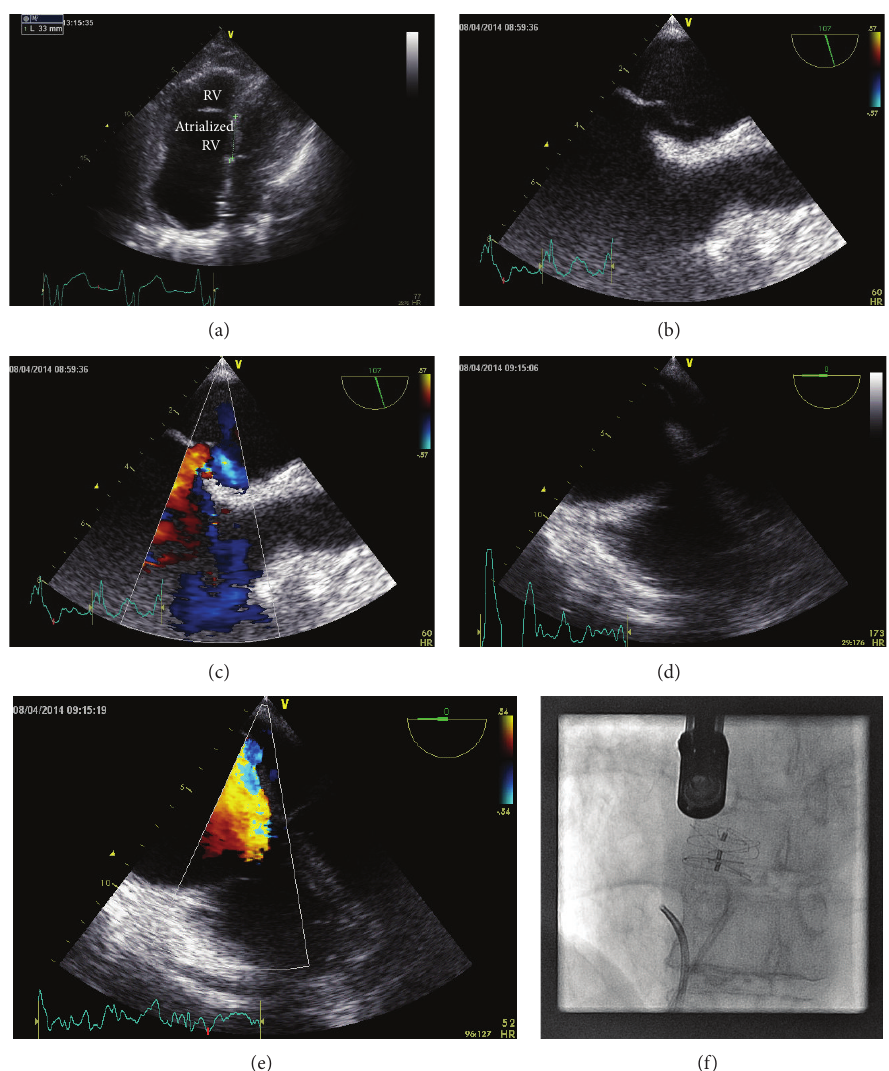
Figure 1: (a) TTE apical four-chamber view, focused on the right heart, showing Ebstein anomaly with atrialization of the right ventricle. (b) TEE image (107 degrees) showing the patent foramen ovale (arrow). (c) TEE image (107 degrees) with color Doppler, showing the patent foramen ovale. (d) TEE four-chamber view (0 degrees) showing the tricuspid valve and the patent foramen ovale. (e) TEE four-chamber view (0 degrees) with color Doppler, showing the eccentric tricuspid regurgitation jet flowing through the patent foramen ovale. (f) Coronary angiogram showing a 20 mm Gore Septal Occluder device used for partial percutaneous patent foramen ovate closure.